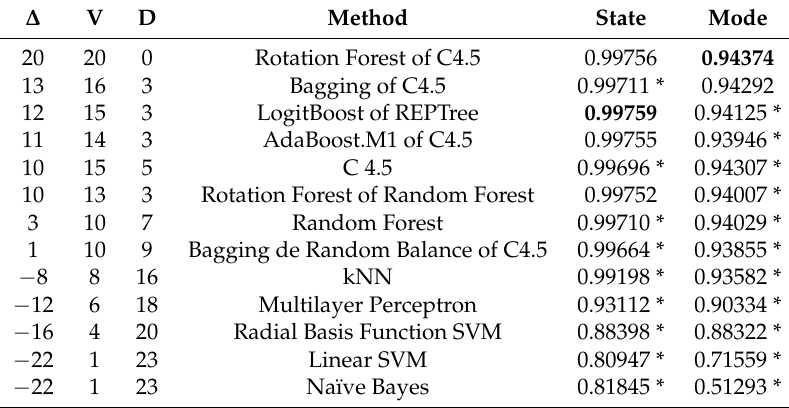
Table 4. Ranking of F-Micro in the classification problems. V is the number of times the method has a better statistically significant F-Micro when compared with the other 12 methods through the 2 predicted variables. D is the number of times the method has a worse statistically significant F-Micro when compared with the other 12 methods through the 2 predicted variables. The ordering criteria ∆ , is equal to V – D. The columns State and Mode have the average F-Micro figures for the method using 10 × 10CV. (*) represents this method has an average F-Micro that is significantly worse than the one for the best-ranked method. The best F-Micros for State and Mode are highlighted in bold.